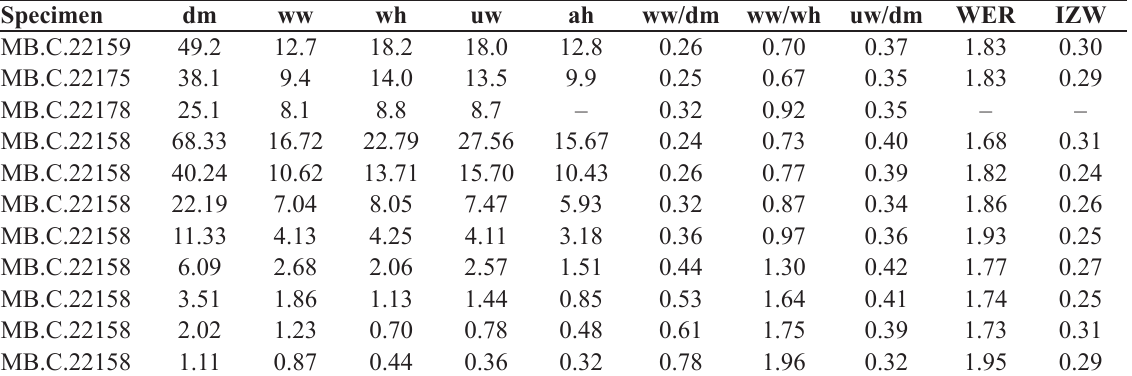
European Journal of Taxonomy 823: 10–47 Table 4. Conch dimensions and ratios of selected specimens of Ponticeras materni sp. nov.